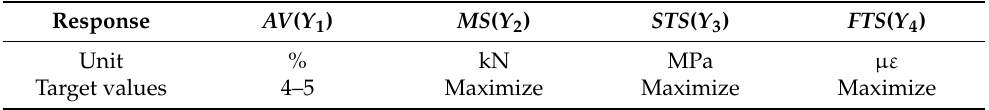
Table 10. Target values of response